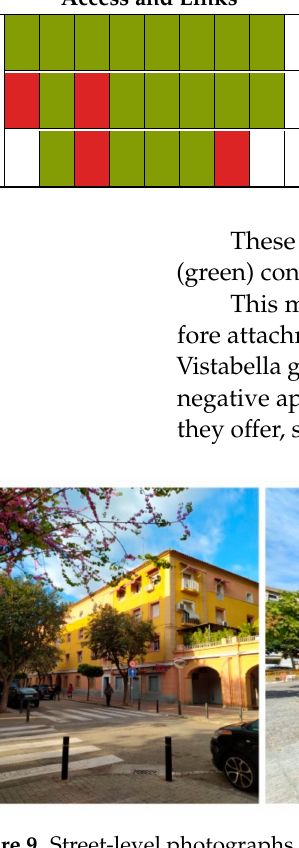
Figure 9. Street-level photographs of Vistabella ( Left ), La Paz ( Middle ) and La Fama ( Right ). Authors’